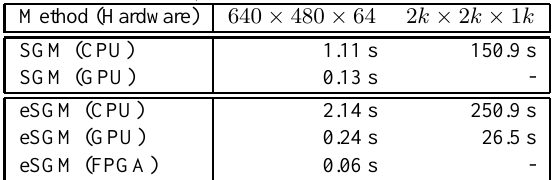
Table 2: Runtime in seconds of SGM and eSGM on one CPU core (Xeon X5570, 3 GHz), GPU (NVidia GeForce G280) and FPGA (Xilinx Virtex 5, 125